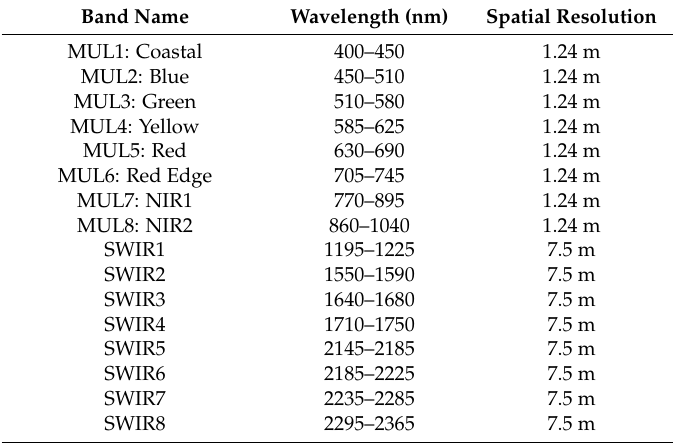
Table 1. Details of the sensor bands of WorldView-3 images acquired for this study